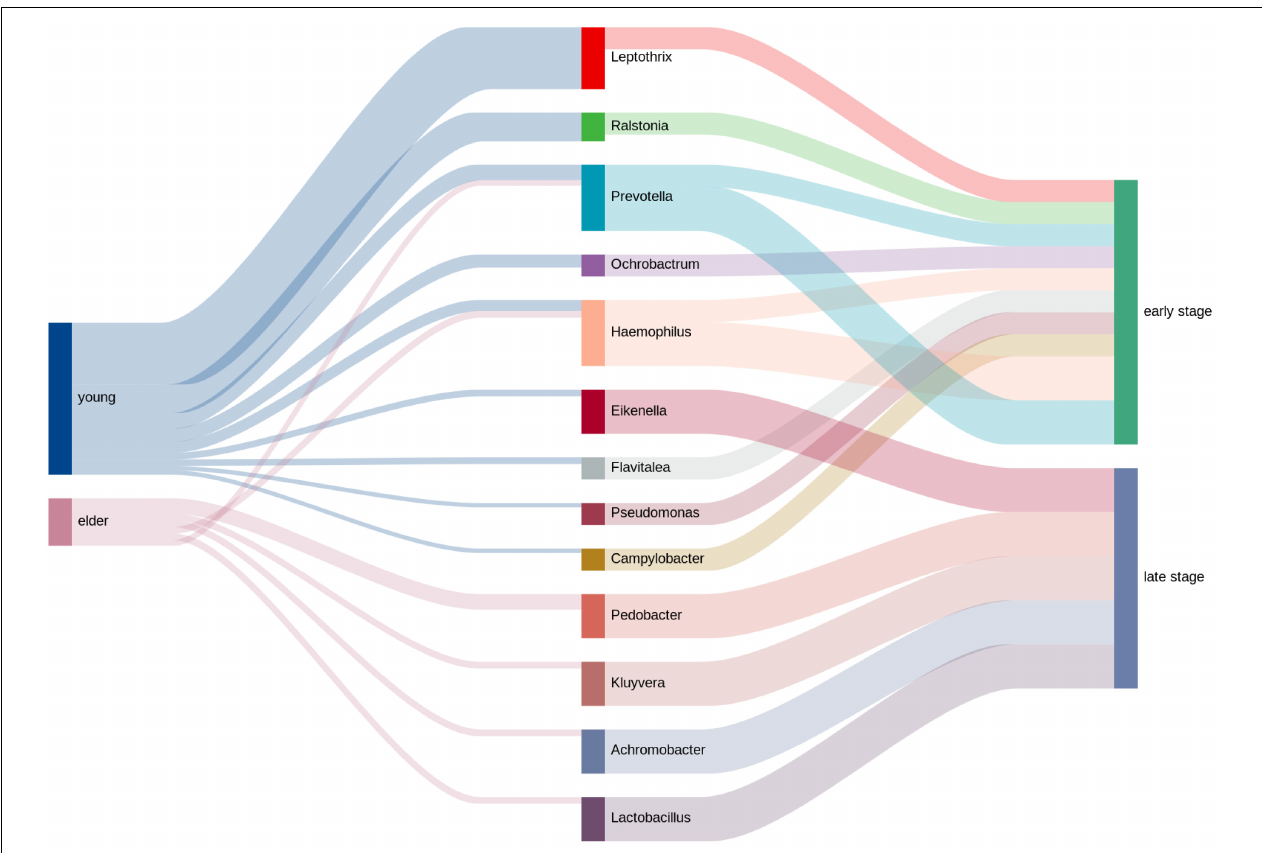
FIGURE 7 | Relative analysis of taxa against tumor stage. The correlations between the top taxa in the younger and elderly OSCC microbiota are shown in the diagram. Thickness of the line of the left half represented the relative richness of the taxa, on the right half thin lines were for taxa from younger group and thick lines were for taxa from elder